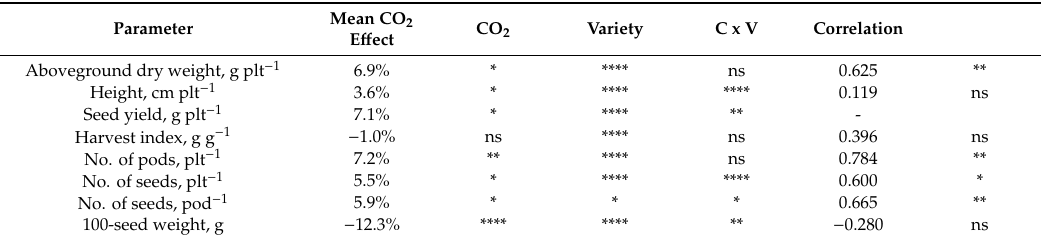
Table 2. Growth and reproductive characteristics at maturity of 17 soybean varieties grown at either ambient (400 ppm) and elevated (800 ppm) CO 2 , and correlations (Pearson’s r) and their statistical significance for the relationship between the relative increase in bean seed yield due to eCO 2 (value at eCO 2 / value at aCO 2 ) and values of other parameters measured under the same conditions. * p < 0.05; ** p < 0.01; **** p <